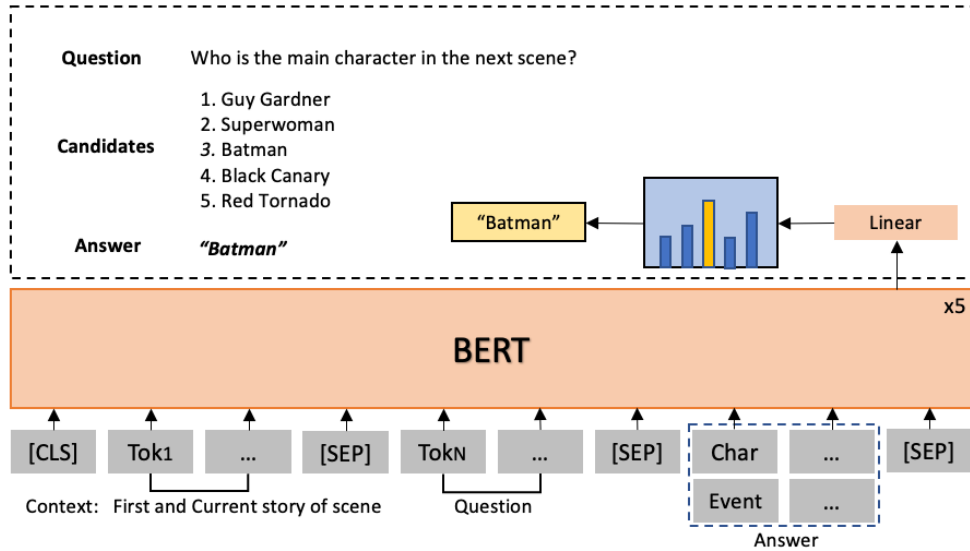
Figure 4. Our proposed storyline guidance model with an example of entity selection and